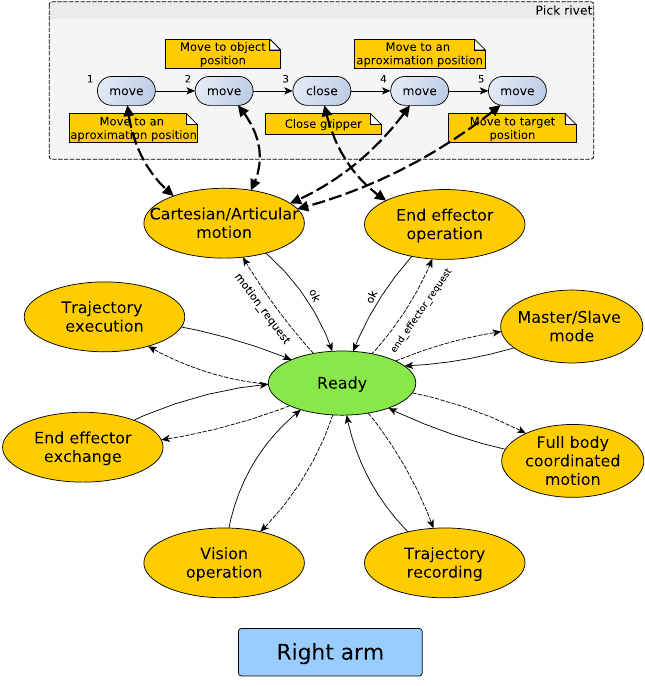
Figure 11. Debur drilling skill mapping into the state